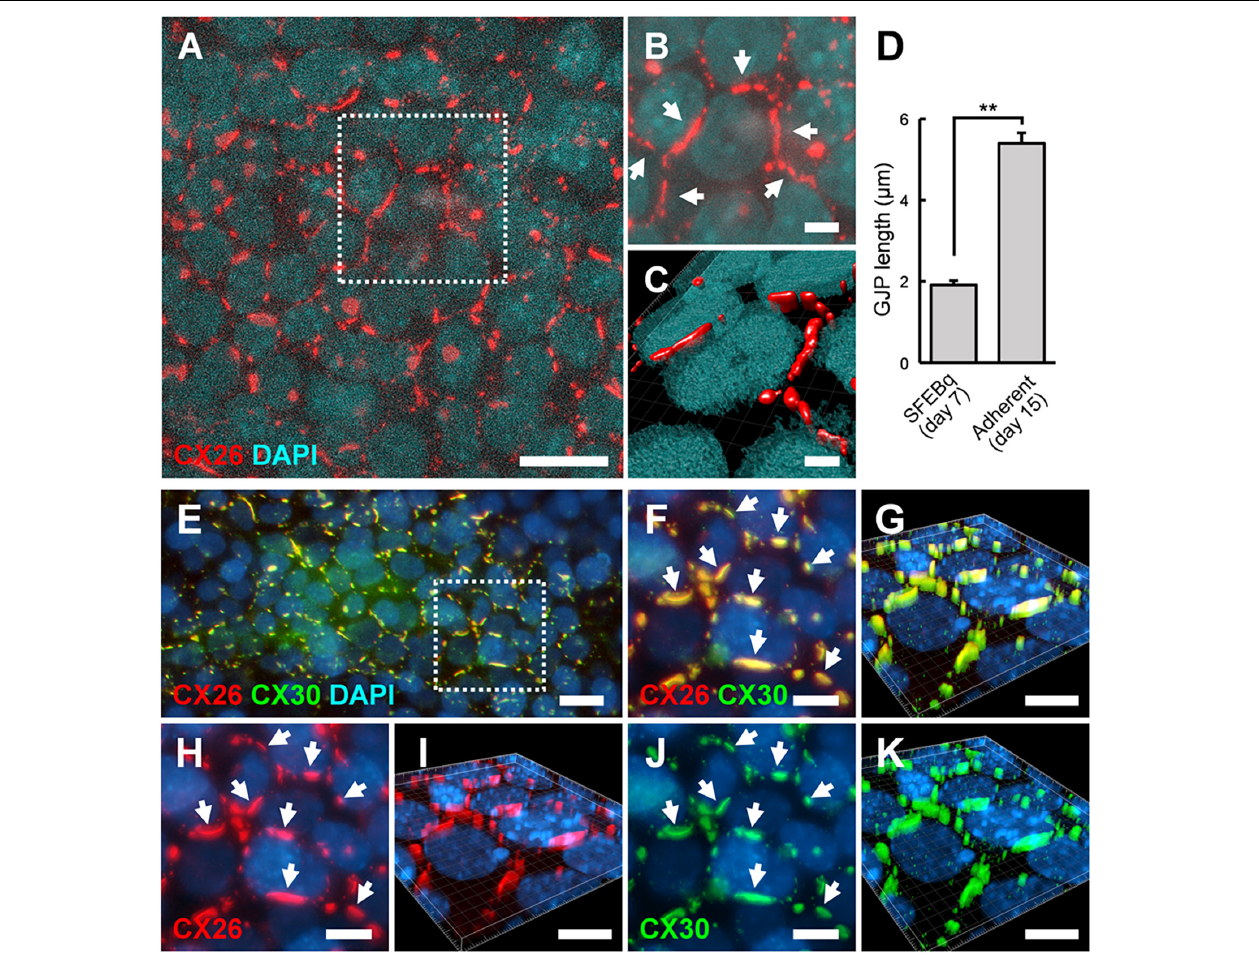
FIGURE 5 | ESC-derived CX26GJCs formed large CX26GJPs and CX26/CX30-containing GJPs. (A) Merged images of CX26-immunostained (red) and DAPI-stained (blue) cells from an adherent culture at day 15. (B) Higher-magnification image of the boxed region in (A) . Arrows point to GJPs. (C) The three-dimensional image was reconstructed from the same region as shown in (B) . (D) Mean lengths of the longest dimension of the GJPs along a single cell border in SFEBq cultures (SFEBq) at day 7 and adherent cultures (Adherent) at day 15 (SFEBq culture, n = 43 cell borders from 5 aggregates; adherent culture, n = 41 cell borders from 4 wells). For assessments, the procedures were repeated three times to generate cells. Statistical differences between samples were assessed by Student’s t -test; ** p < 0.01. The data are expressed as the mean ± SE. (E) Merged images of CX26-immunostained (red), CX30-immunostained (green), and DAPI-stained (blue) cells from adherent cultures at day 15. (F,H,J) Higher-magnification image of the boxed region in (E) . Staining for CX26 (red), CX30 (green), and DAPI (blue). Arrows point to the large GJPs. (G,I,K) The three-dimensional images were reconstructed from (F,H,J) , respectively. Arrows point to the large